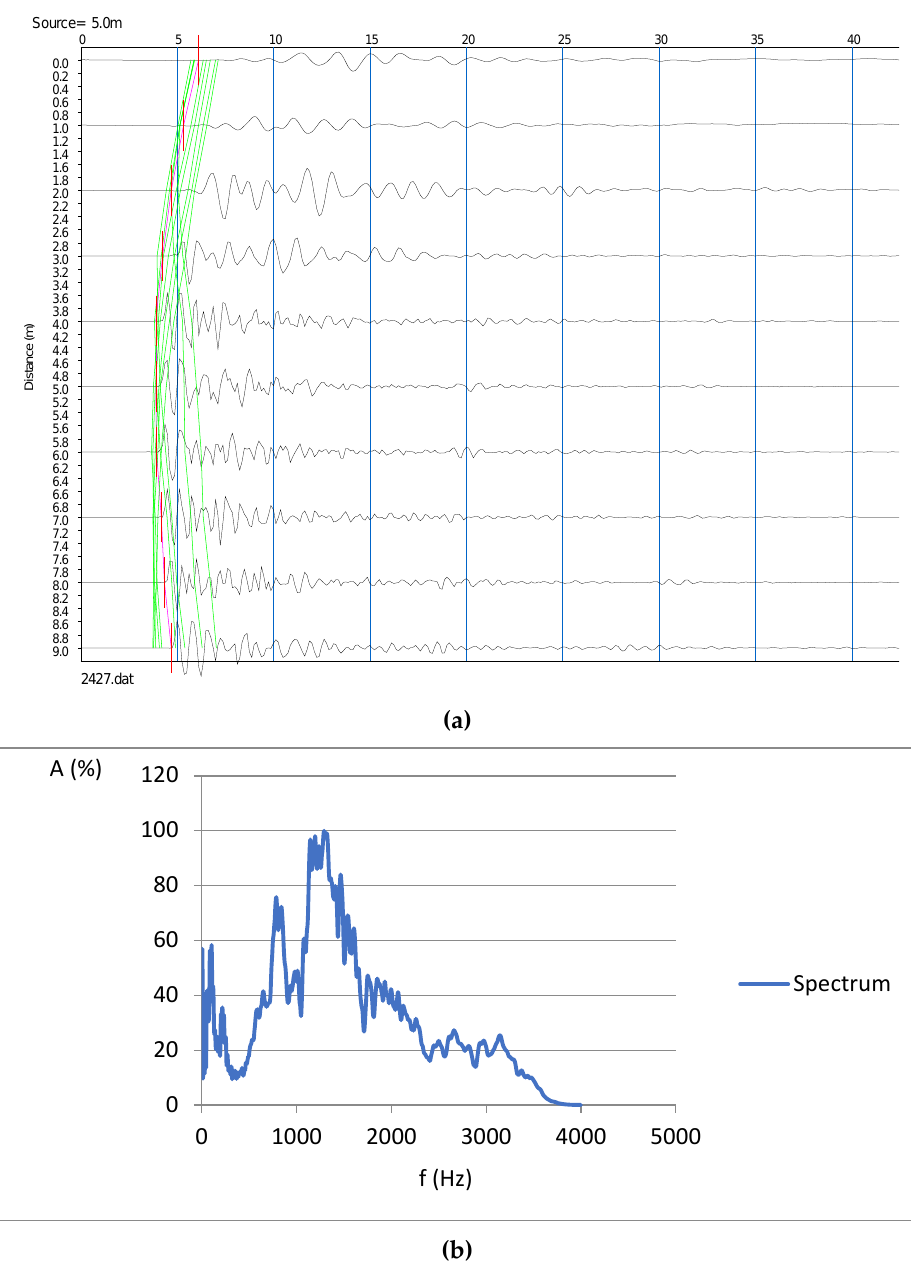
Figure 3. ( a ) A seismic dataset fragment with highlighted arrivals of P-waves (Pickwin, version 5.2.1.3). Red line: arrivals picked while the source was at a depth of 5.0 m; green line: arrivals picked at other positions of the source. ( b ) Spectrum of all the recorded signals: the useful signal is characterized by frequencies approximating 834 Hz.